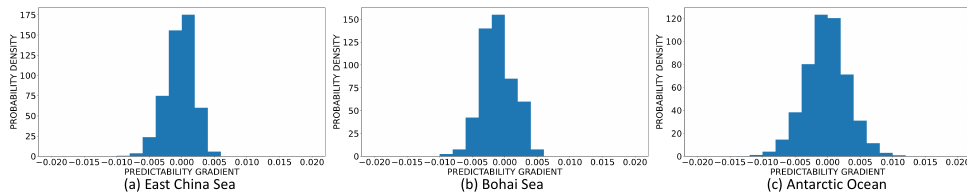
Figure 19. The probability density of the gradient of SST predictability in ( a ) the East China Sea, ( b ) the Bohai Sea, and ( c ) the Antarctic